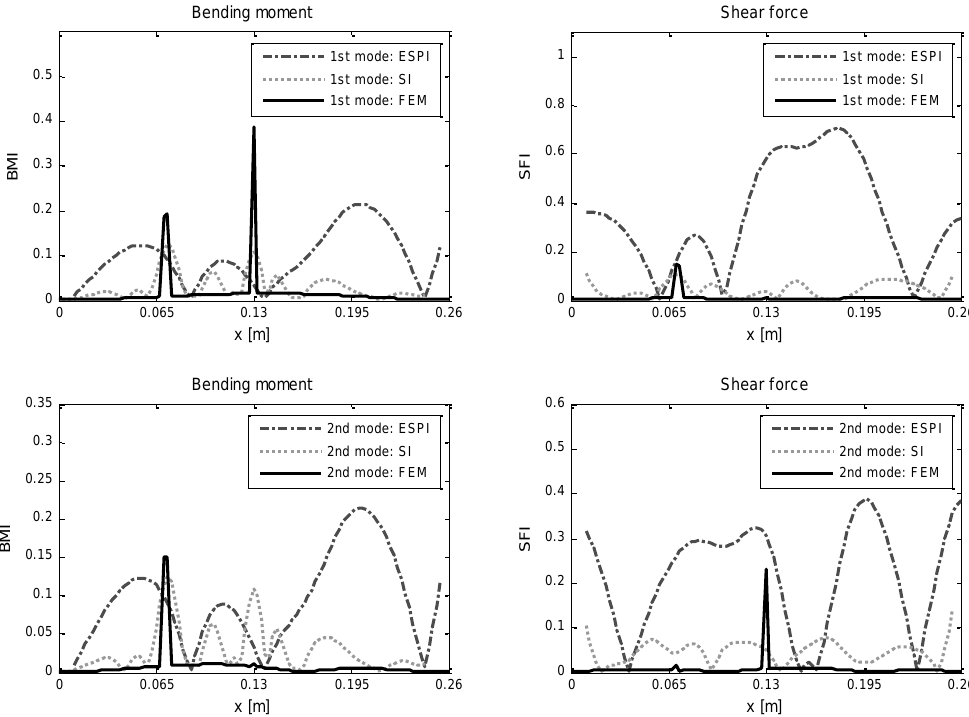
Fig. 5. BMI and SFI values of the first and second mode shapes using the pulsed ESPI, pulsed shear (SI) interferometric systems and the finite element method (FEM) for the fourth damage